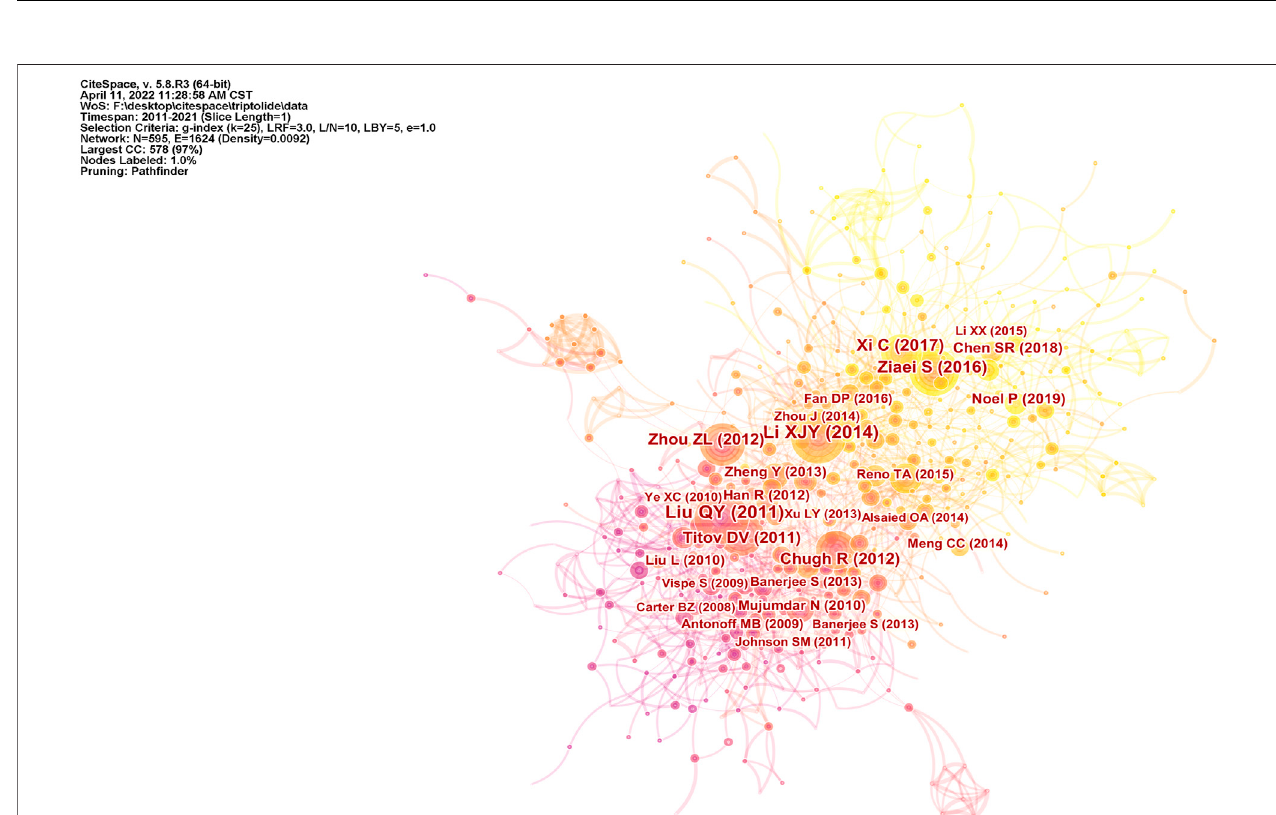
FIGURE 11 | Document co-citation analysis from the WOS.